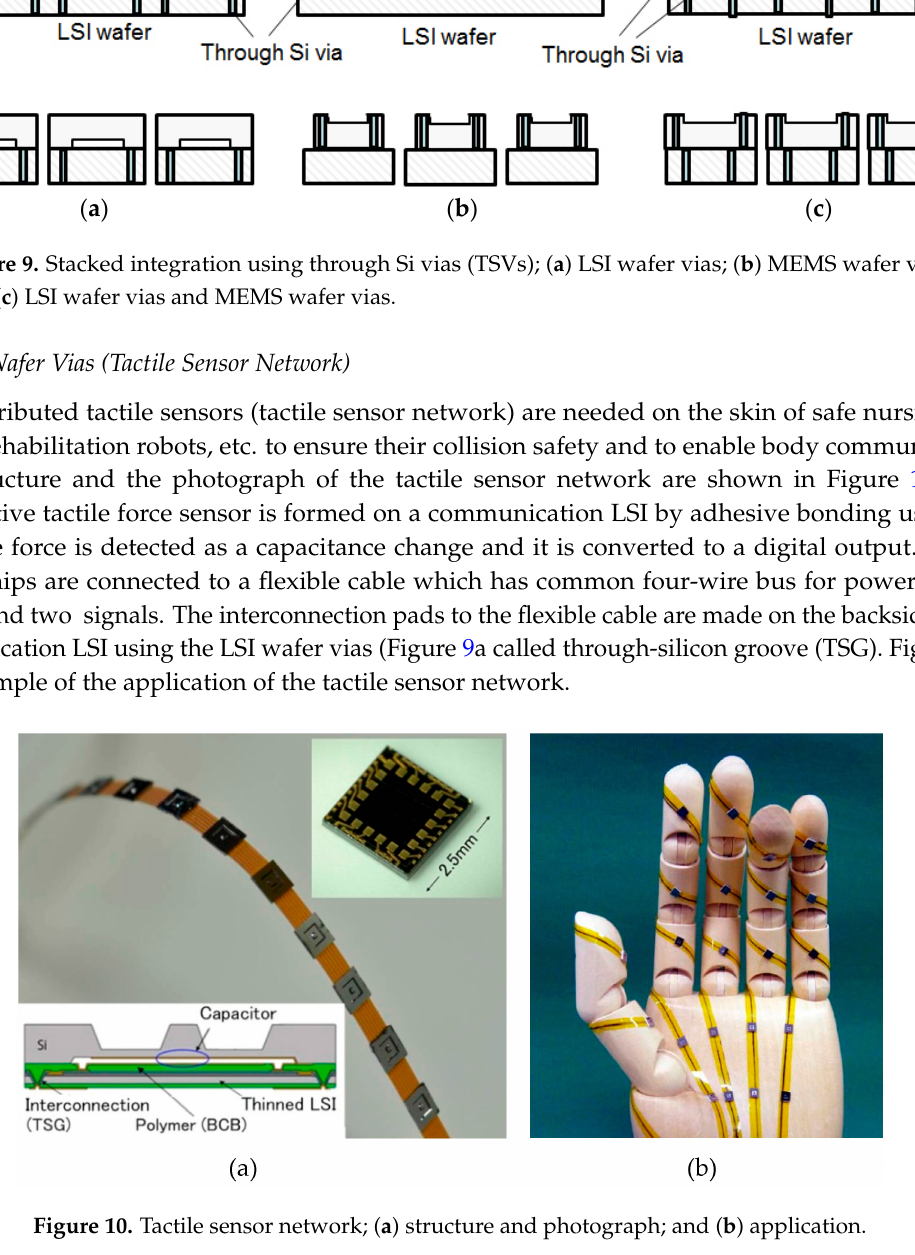
Figure 10. Tactile sensor network; ( a ) structure and photograph; and ( b ) application.